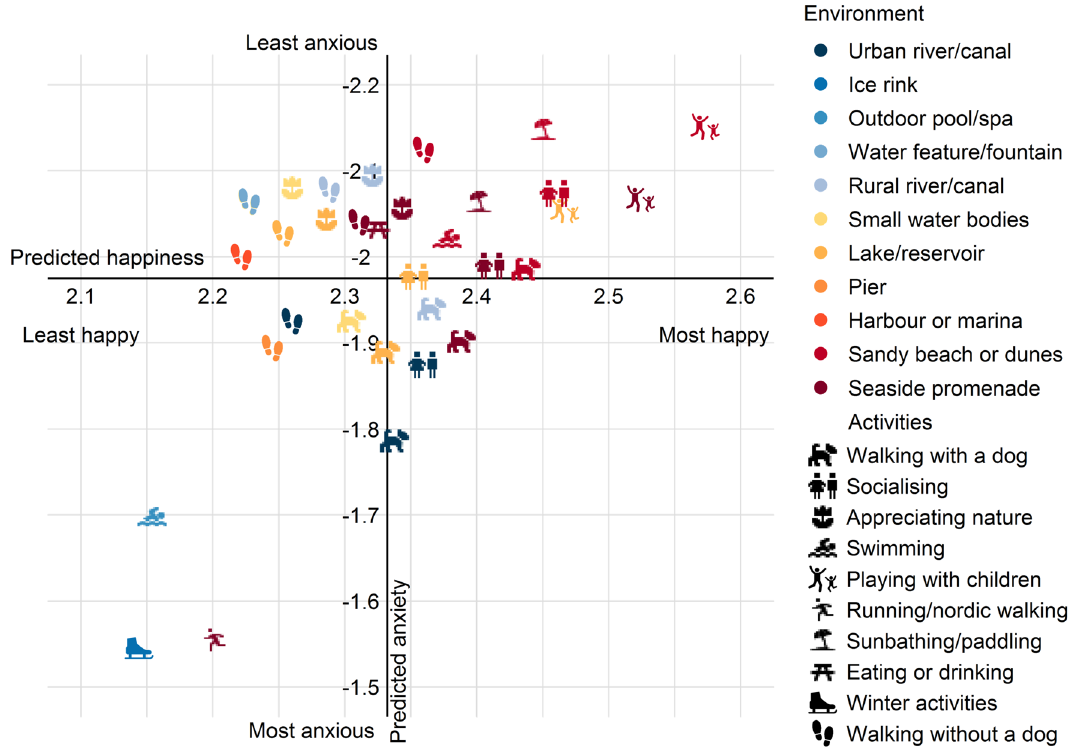
Figure 4. Predicted well-being outcomes by bluespace and activity. Predicted visit anxiety and happiness for combinations of activity and bluespace type where there were at least 100 visits. Predictions are based on fully adjusted models (Step 3) with varying activity and bluespace type. Predictions are the mean predicted anxiety and happiness from 2000 runs for each combination of activity and bluespace type. Environmental qualities, visit duration, travel characteristics and WHO-5 well-being index are specified when predicting with fixed values. All other variables are specified by drawing randomly from the distribution of the full dataset (see method). The origin of the x and y axes are the mean predicted happiness and anxiety respectively. Note that predicted visit anxiety is displayed with a reversed scale such that better well-being is at the